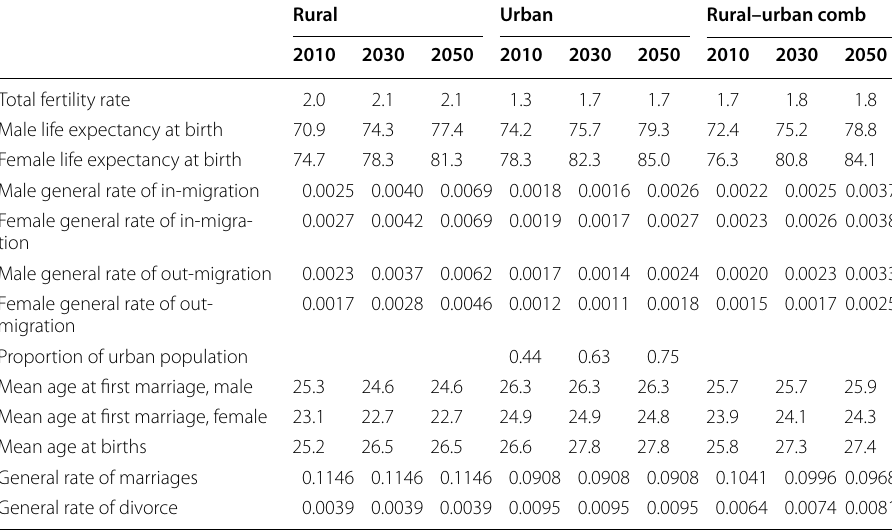
Table 2 Main demographic parameters 2010–2050, Hebei Province, China